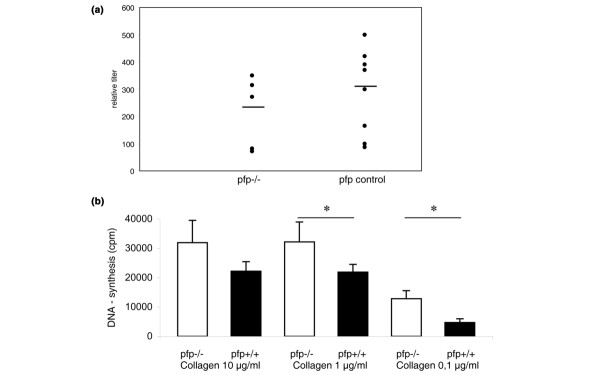
Antibody response and T cell proliferation. (a) No significant variations in the levels of collagen-specific IgG antibodies between the perforin (pfp)-deficient mice (n = 6) and the control littermates (pfp+/- and pfp+/+; n = 10) were seen. Sera were obtained from the mice 21 days after immunization with collagen type II (CII) and complete Freund's adjuvant (CFA). Levels of collagen-specific IgG antibodies were measured by quantitative ELISA. (b) pfp-/- mice show an increased proliferation toward CII. Draining lymph nodes were obtained from pfp-/- (n = 3) and pfp+/+ (n = 3) mice 90 days after immunization with CII in CFA. The cells were cultured for 60 hours with collagen II in different concentrations, and then pulsed with [3H]thymidine. *P < 0.05.